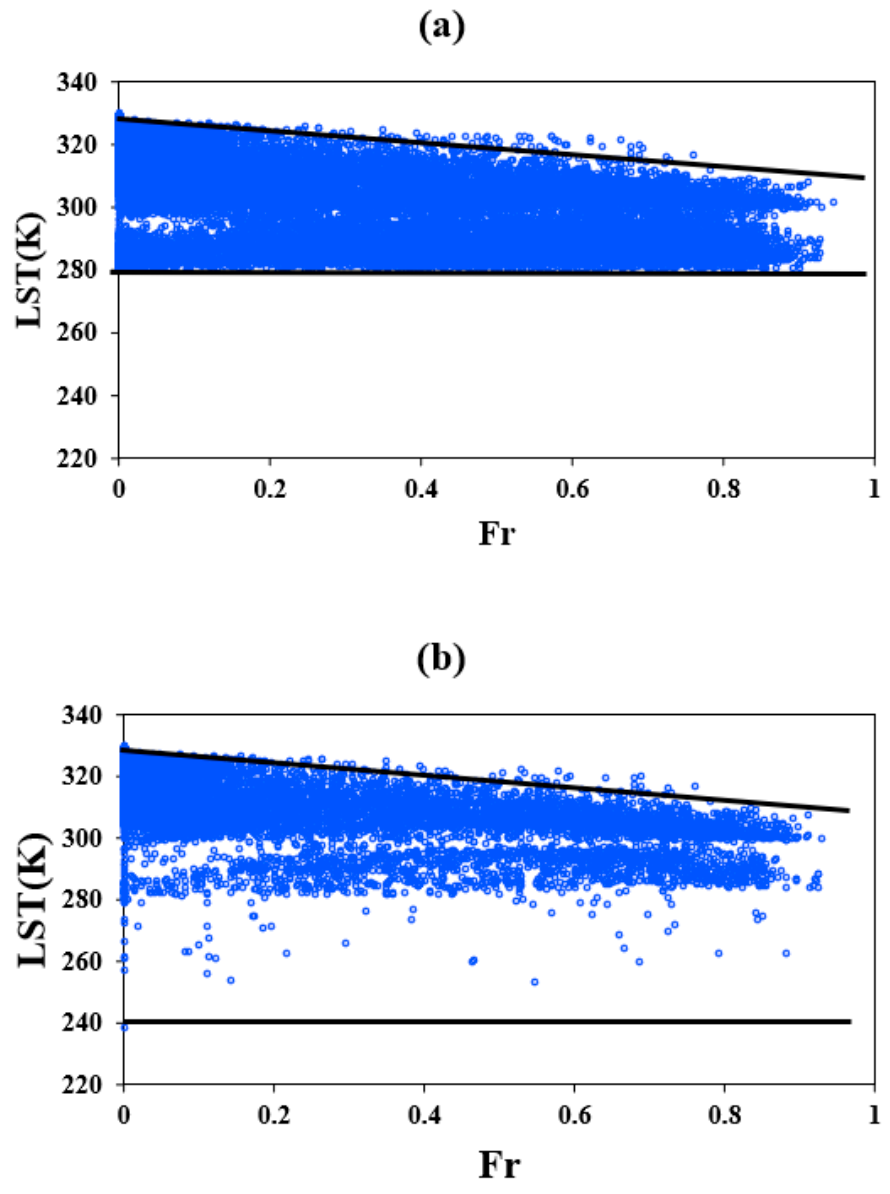
Figure 7. Scatter plots of 209th in 2009 for: ( a ) after and ( b ) before reconstruction; wet and dry edges are shown as black lines, where LST: land surface temperature; Fr: fractional vegetation cover.